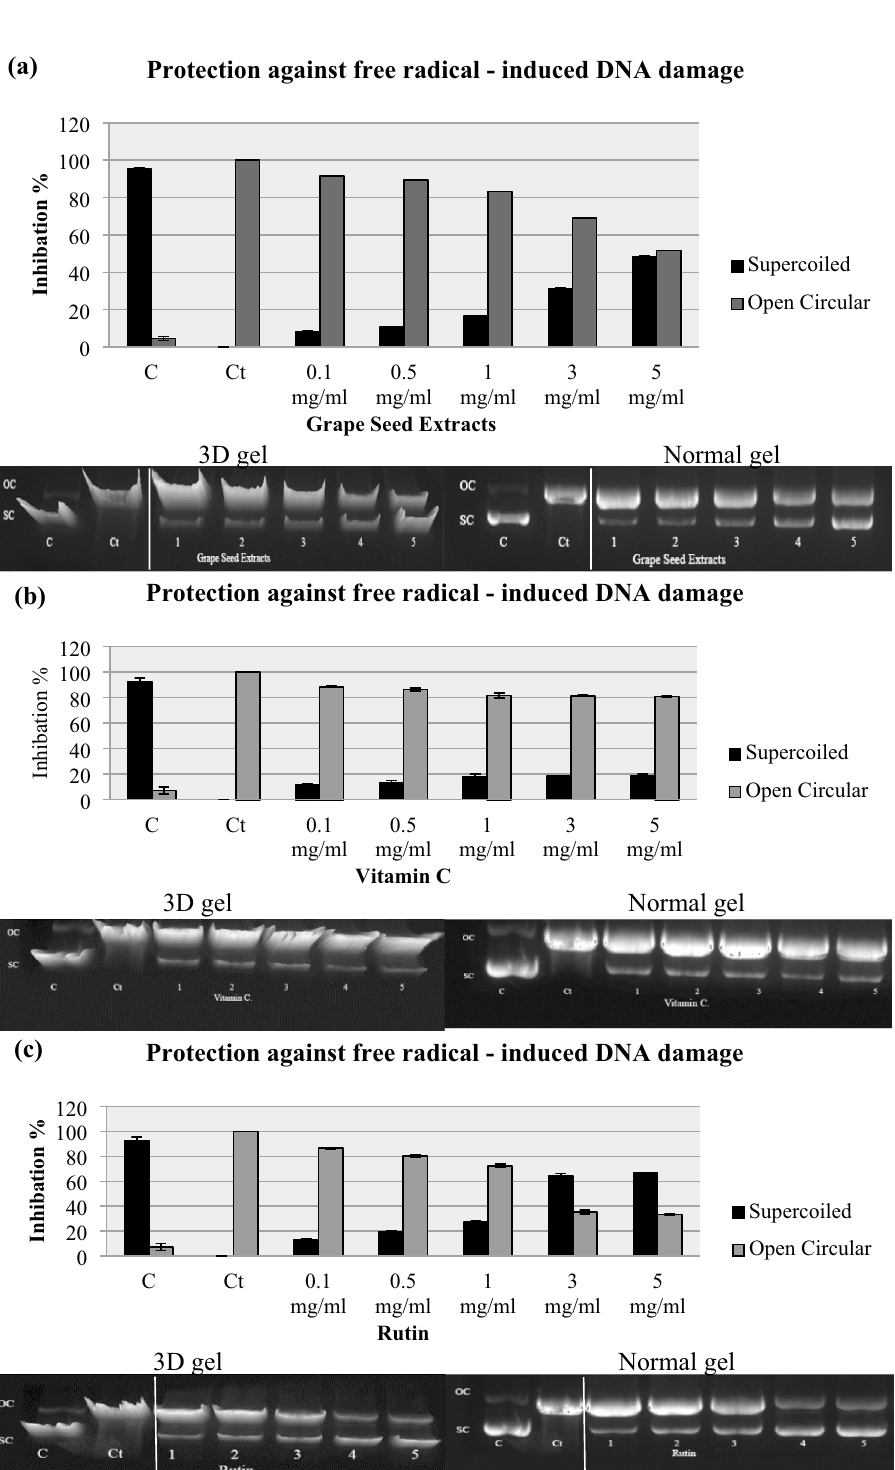
Figure 3. pBR322 DNAdamage inhibition activities of ( a ) VGSE, ( b ) VC, and ( c ) rutin at different concentrations. Lane1’C’: pBR322 DNA; Lane2’Ct’: pBR322 DNA + H 2 O 2 + UV; Lane 3–7: pBR322 DNA + H 2 O 2 + UV + VGSE, VC, or rutin at different concentrations (0.1–5 mg/mL); C and Ct are cropped from different parts of the same gel. Values are means ± SD of three experiments. Images were captured using Image lab 4.1 software (version 6.1.0 build